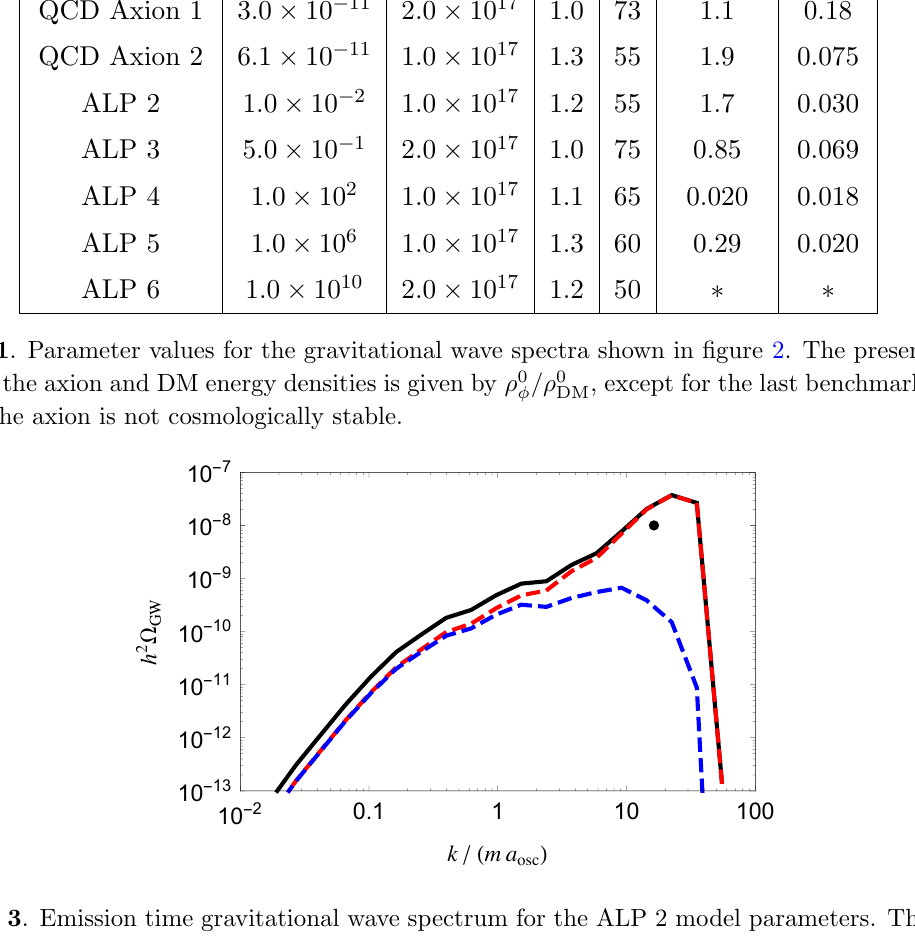
Figure 3 . Emission time gravitational wave spectrum for the ALP 2 model parameters. The solid black line gives the total spectrum while the dashed lines show the contributions from the \+ 00 (red) and \ (cid:0) 00 (blue) helicities of the